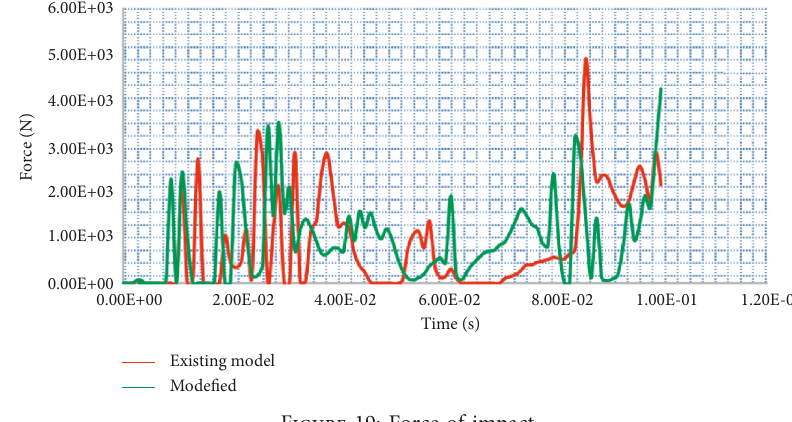
Figure 19: Force of